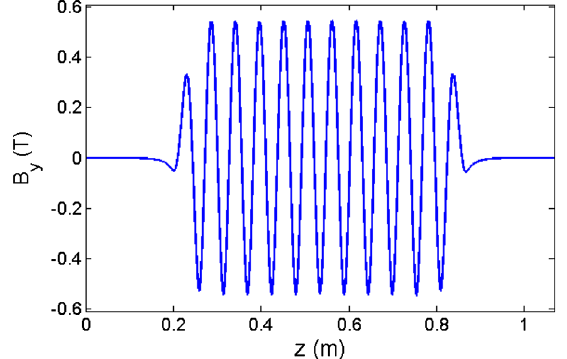
FIG. 1. Measured magnetic fields of the 10-period undulator U55 with K ¼ 2 : 76 at various longitudinal positions.